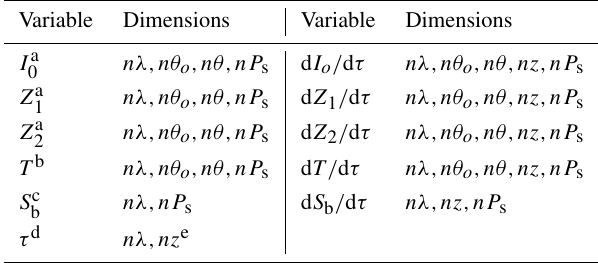
Table 3. LUT variable